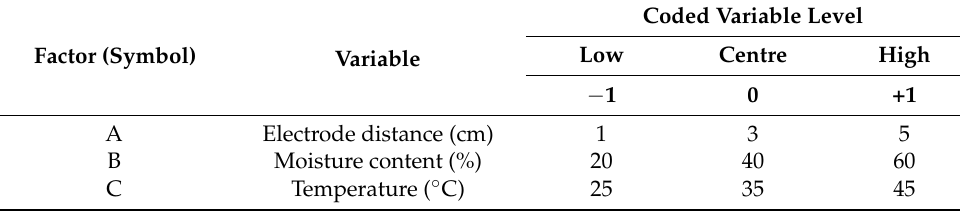
Table 7. Variable levels determined via